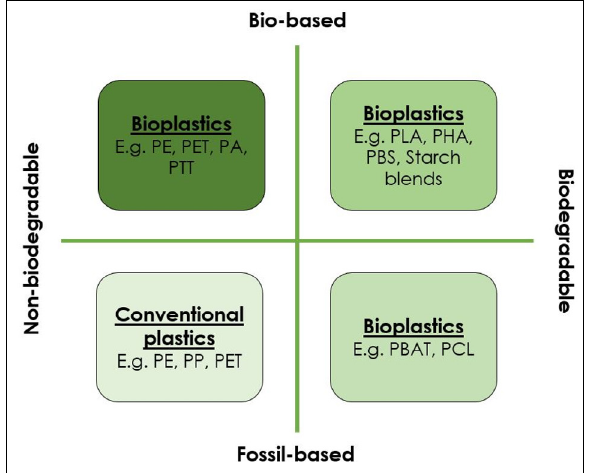
Different categories of plastics and bioplastics.